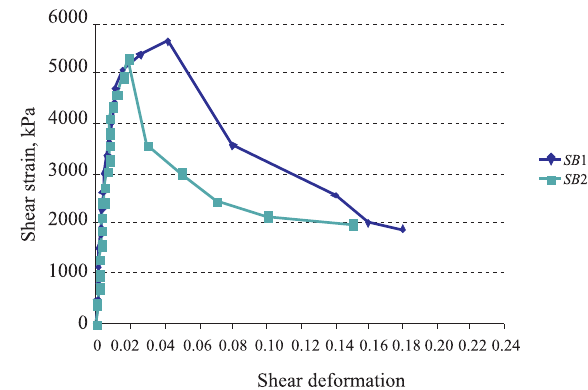
Fig. 11. Experimental results for SB 1 and SB 2 beams